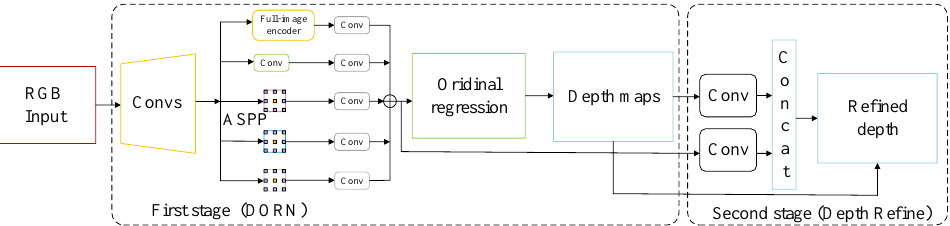
Figure 3. The Architecture of Translation Estimation Module. Convs represents ResNet50. Conv